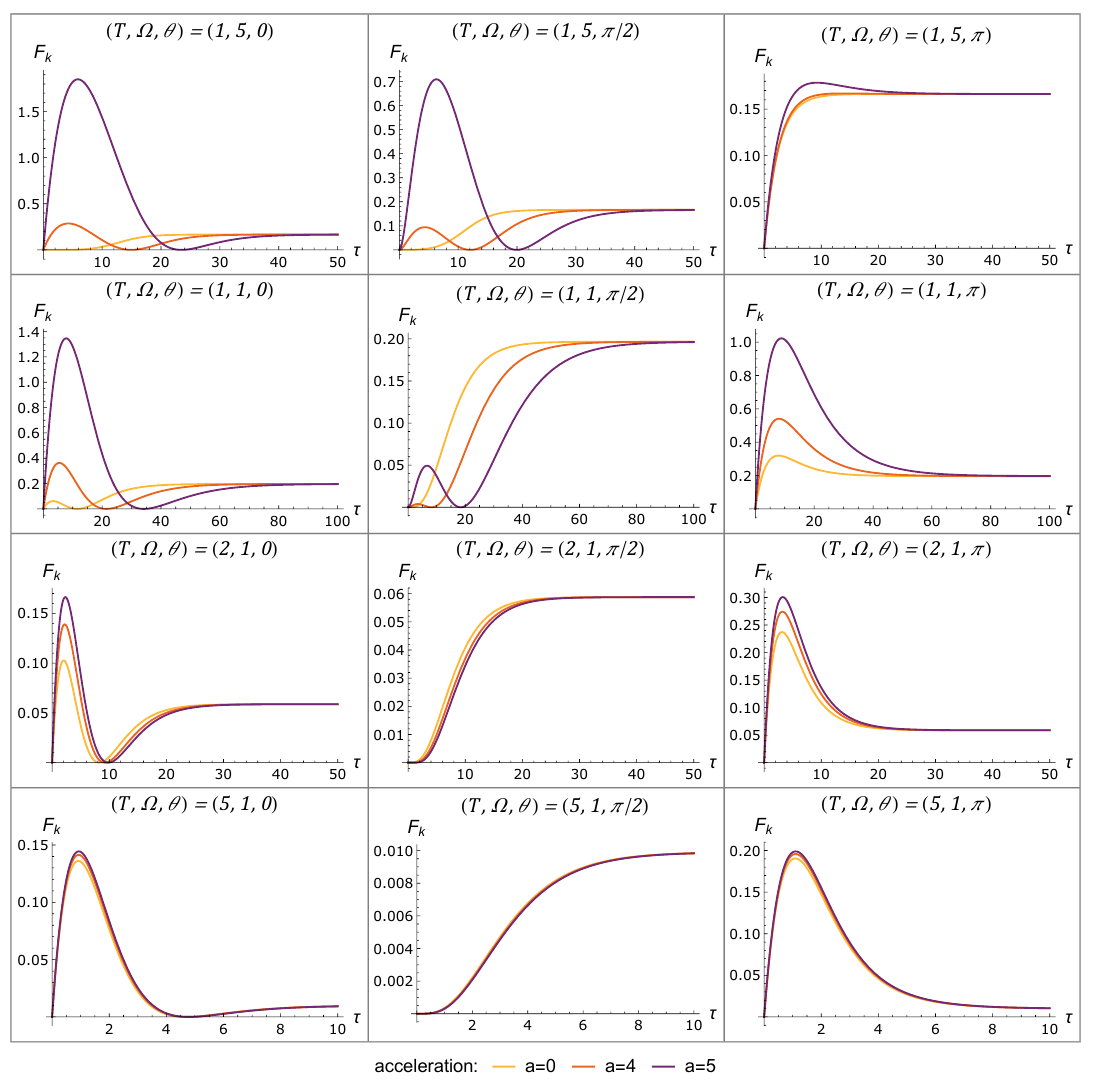
Figure 2 . The effect of acceleration on the Fisher information for a detector in dS 4